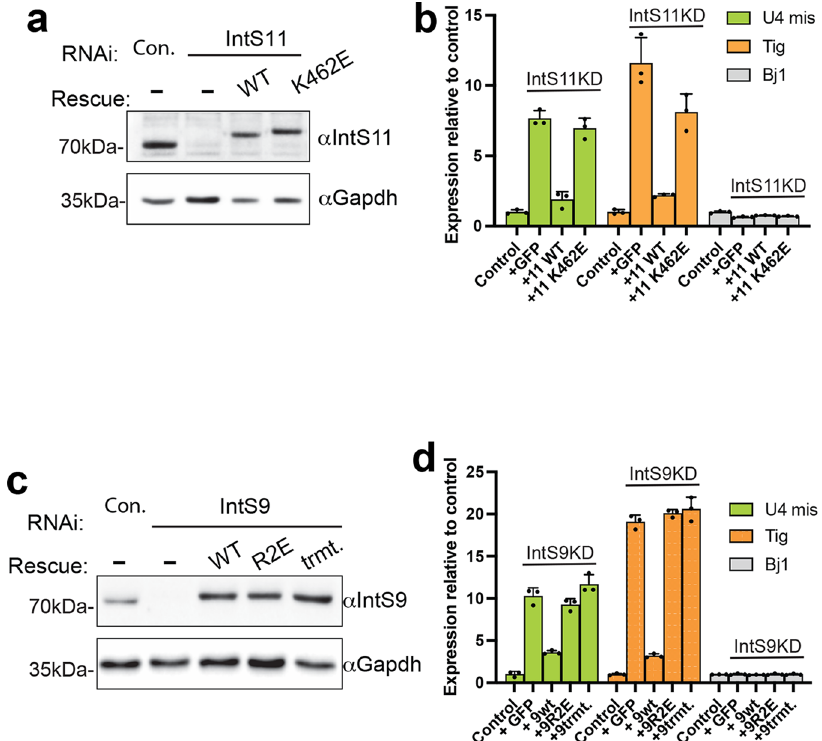
Fig.7|IP 6 isimportantforIntegratorfunction.a WesternblotanalysisofDL1cell lysatesderivedfromcellstreatedwitheithercontrolorIntS11dsRNA.Rescueswere conducted in cells depleted of IntS11 through the inducible expression of RNAi- resistant cDNA. b RT-qPCR analysis of selected genes identi fi ed to be upregulated upon IntS11 depletion using RNA-seq. Results are shown from biologically inde- pendent replicates, depicting averages and standard deviations (mean±SD, n =3). c Western blot analysis of DL1 cell lysates derived from cells treated with either